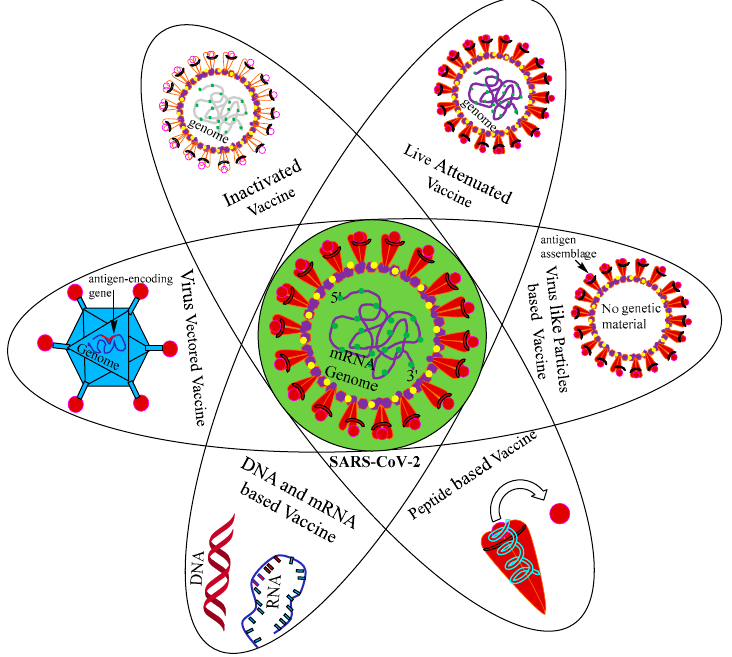
Figure 1. Multiple types of vaccine available and/or under various phases of development for COVID-19.